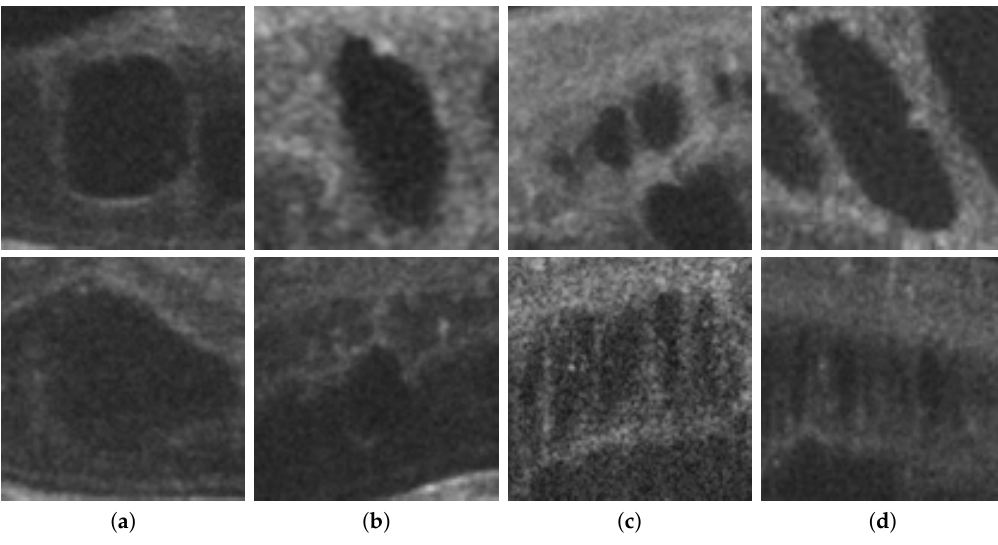
Figure 2. Examples with accumulations of intraretinal fluid with adequate definition for a segmentation (1st row) and counter-examples with blurred, merged, and obfuscated edges that are hard to segment precisely (2nd row). ( a , b ) Individual cystoid fluid bodies. ( c , d ) Groups of fluid